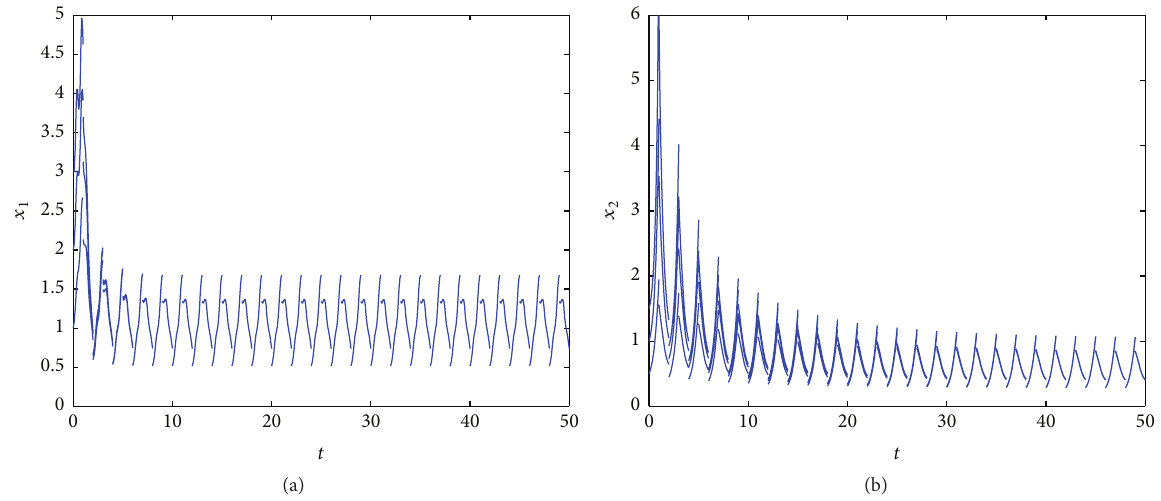
Figure 1: Dynamical behavior of system (74) for 𝑖 = 1 (a) and 𝑖 = 2 (b), the unique globally attractively positive 2 -periodic solutions 𝑥 ∗ 1 (𝑡) and 𝑥 ∗ 2 (𝑡) . Here, we take initial values 𝑥 110 = 3, 𝑥 120 = 2, 𝑥 130 = 1, 𝑥 210 = 1.5, 𝑥 220 = 1 , and 𝑥 230 = 0.5 .